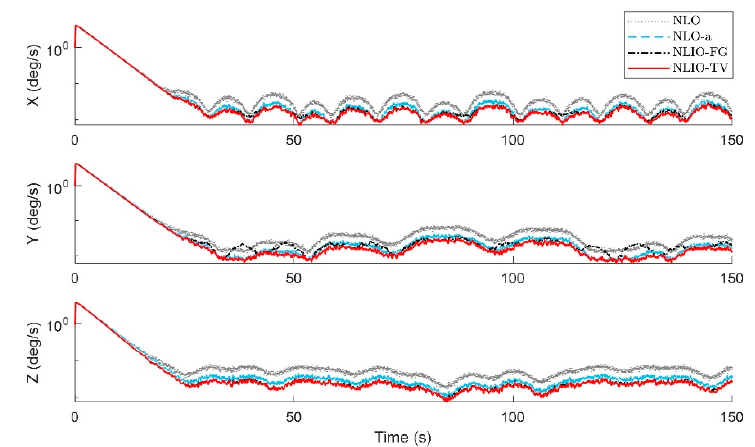
Sensors 2020 , 20 , x FOR PEER REVIEW Figure 4. Averaged absolute attitude estimation error over 100 simulations for Case 1.